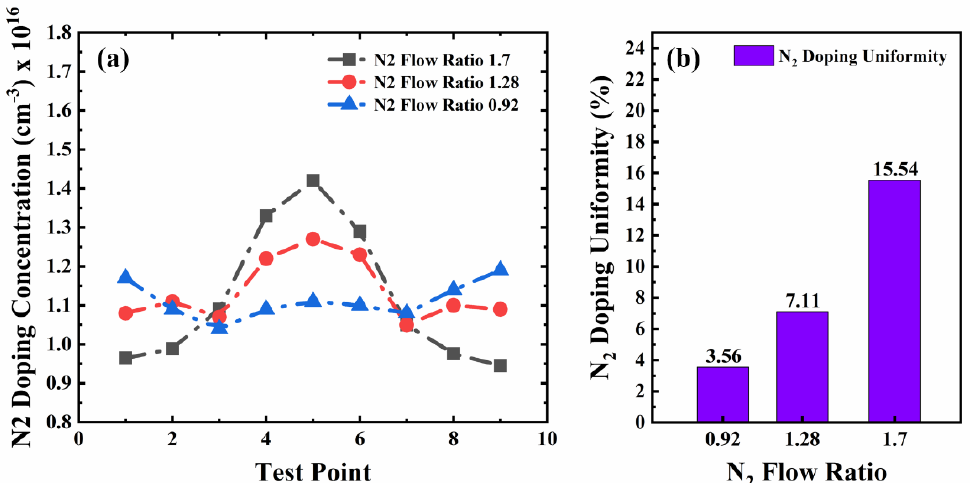
Figure 6. Influence of N 2 flow ratio on ( a ) radial distribution of doping concentration and ( b ) doping uniformity of the wafer.